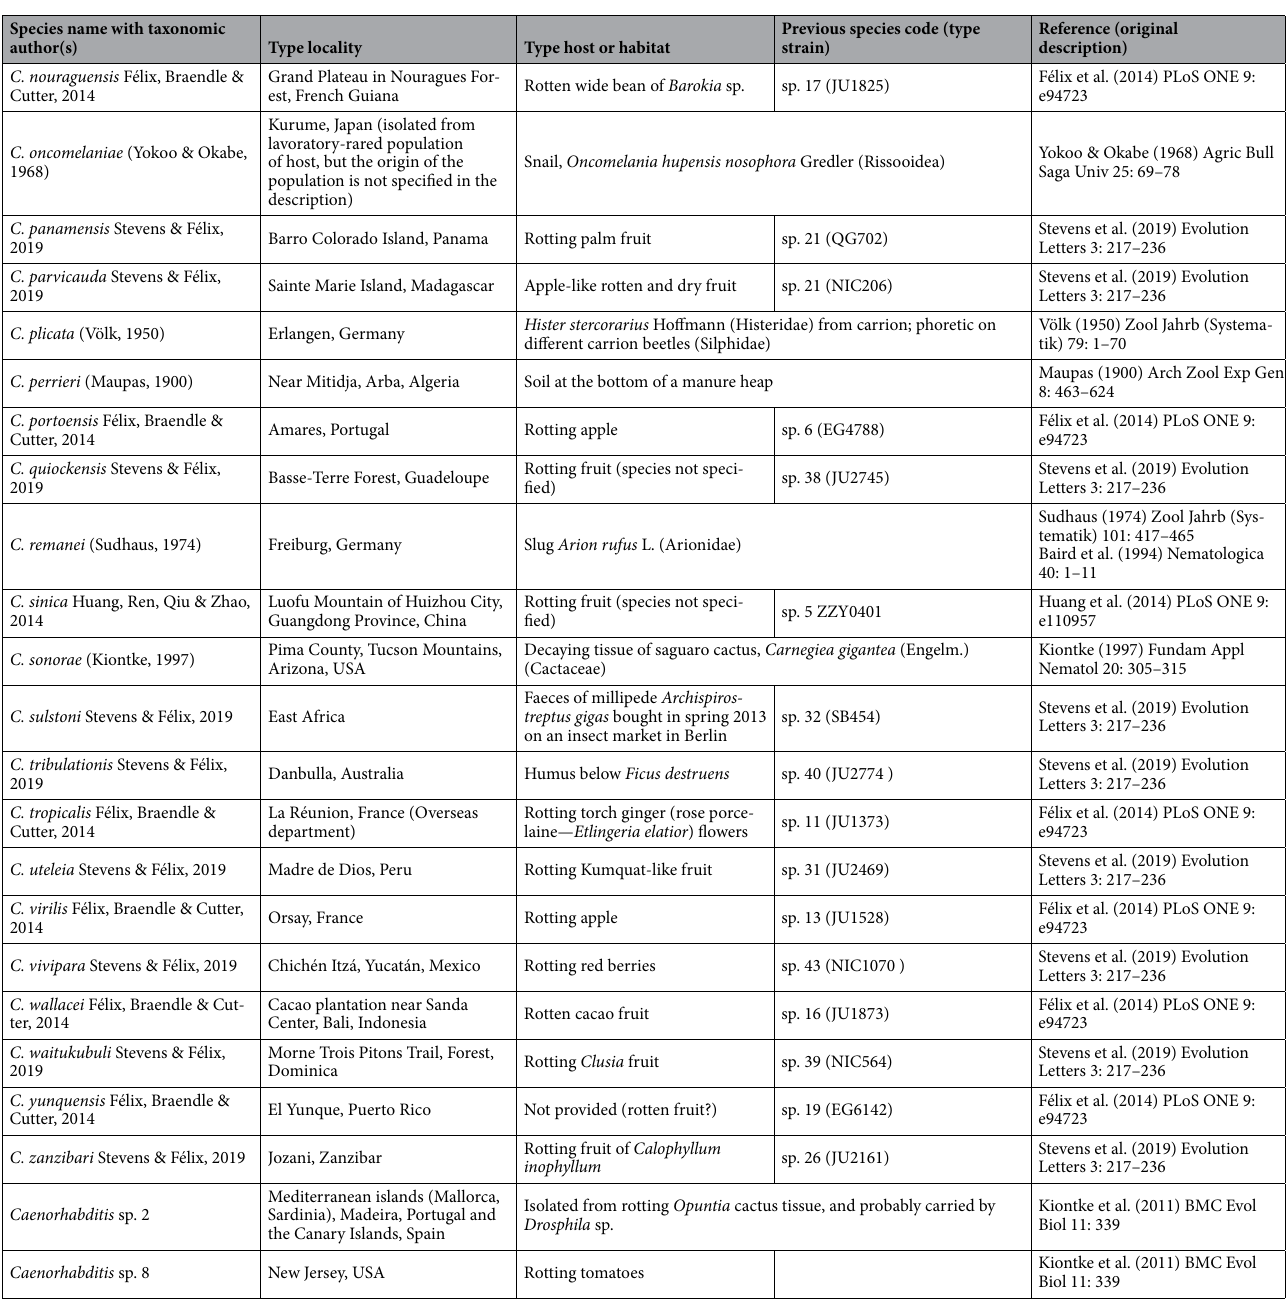
Table 1. List of nominal and characterized Caenorhabditis species including type locality, and type host or